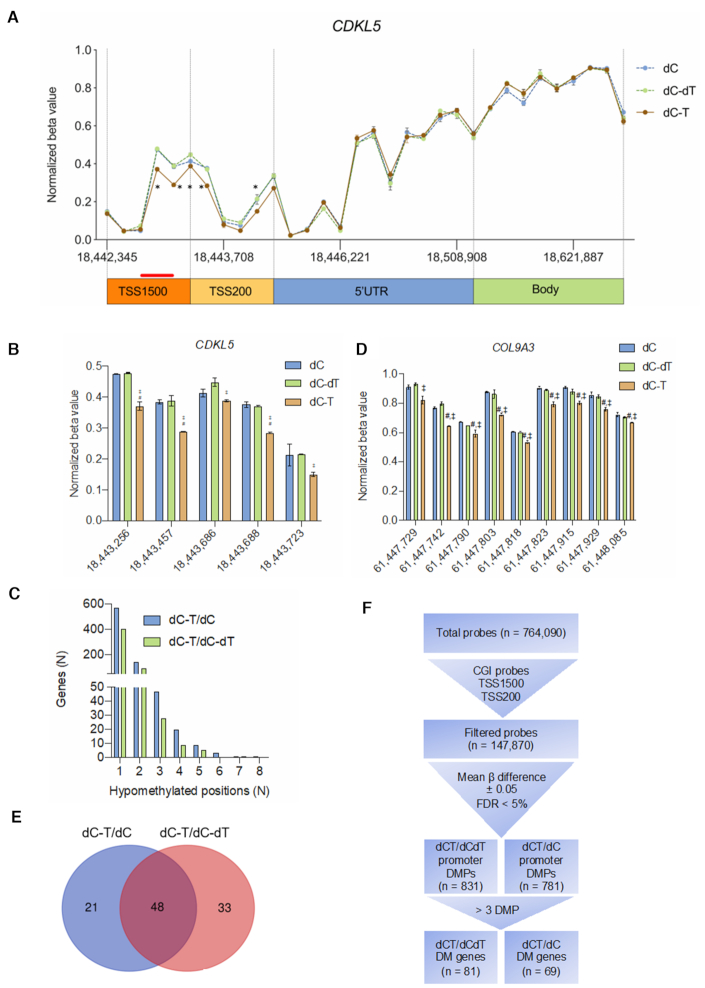
Global DNA hypomethylation due to constitutive dCas9-TET1CD expression. (A) Thirty-two CpG positions shown with their respective location on the X-chromosome (hg19) from the 850K MethylationEPIC array across the CDKL5 promoter were used to assess gene-wide changes in DNA methylation levels represented as changes in the beta value of the TSS200, TSS1500, 5′UTR and gene body of CDKL5. After transduction with dCas9-no effector (dC), dCas9-TET1CD (dC-T) and a catalytically inactive TET1CD (dC-dT), we found reduced DNA methylation levels in the TSS1500 and TSS200 region of cells transduced with dCas9-TET1CD. The red line demonstrates the sgRNA binding sites in the CDKL5 promoter. *Significantly differentially methylated positions for further assessment. (B) Side-by-side assessment of significantly differentially methylated positions in the CDKL5 promoter with a mean difference in beta value of <0.05. #Significantly different from dC, †significantly different from dC-dT, n = 2 independent experiments, FDR < 5%. (C) Histogram of the number of genes by the number of significantly hypomethylated sites of dCas9-TET1CD transduced cells when compared to dCas9 or a catalytically inactive TET1 fused to dCas9 demonstrates that the majority of genes shows only a single probe falling within the respective promoter region. (D) Side-by-side assessment of significantly differentially methylated positions in the COL9A3 promoter with a mean difference in beta value of <0.05. #Significantly different from dC, †significantly different from dC-dT, n = 2 independent experiments, FDR < 5%. (E) Venn diagram of shared genes between dCas9-TET1CD comparisons with dCas9 or a catalytically inactive TET1CD mutant shows an overlap of 48 genes between the two groups. (F) A flow chart diagram representing the analysis pipeline for genome-wide methylation effects of dCas9-TET1CD, starting from a total number of probes, down to significantly differentially methylated sites and ultimately differentially methylated genes.